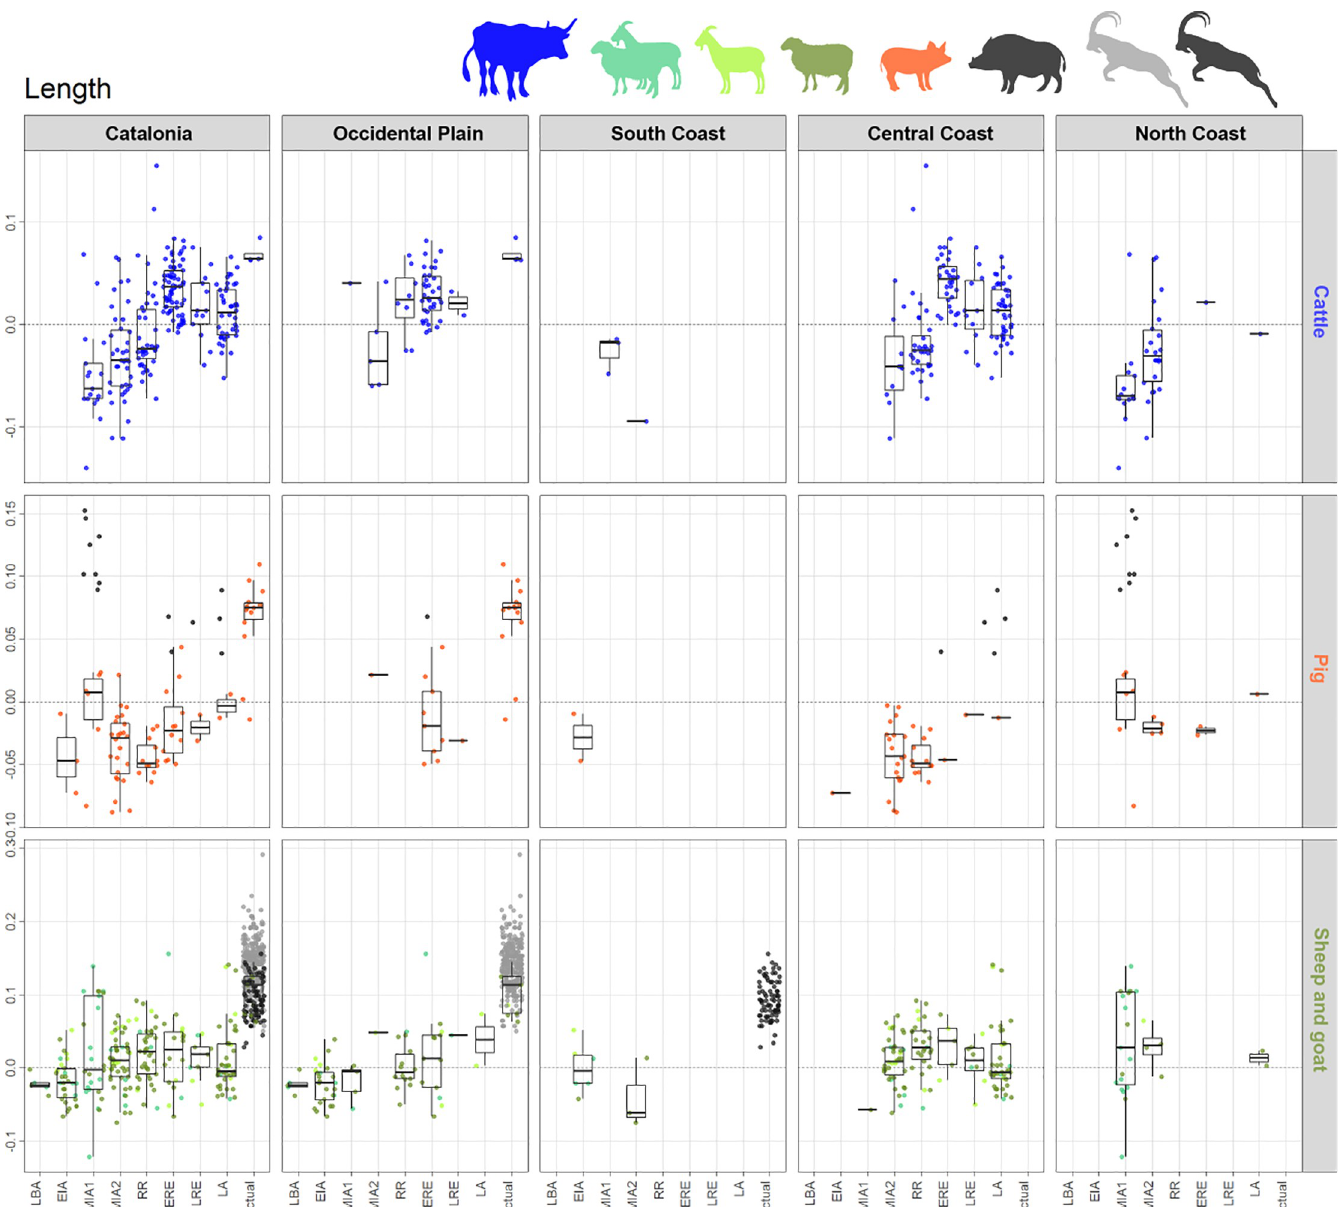
Fig 7. Length LSI values distribution diagram of cattle, pig and sheep/goat bones, by species (in rows) and geographical areas (in columns). Sheep and goats were considered together (see text for details). For each cell of the diagram, LSI values are displayed on the y-axis and chronological periods on the x-axis: LBA: Late Bronze Age, EIA: Early Iron Age, MIA1: Middle Iron Age 1, MIA2: Middle Iron Age 2, RR: Roman Republic, ERE: Early Roman Empire, LRE: Late Roman Empire, LA: Late Antiquity. Box plots quartiles measures only represent statistics on main domesticates, i.e. wild individuals values are displayed but excluded from statistics. Wild individuals: wild boar (black points), actual Capra pyrenaica hispanica (black points), modern Capra pyrenaica pyrenaica (grey points) [15]; actual Xisqueta breed sheep and Catalan goat breed.